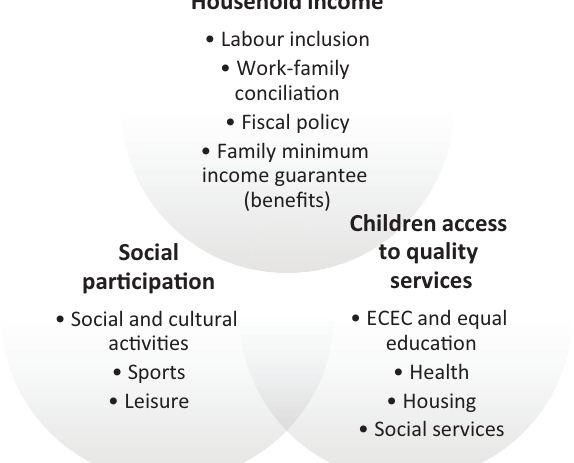
Figure 2. Model of analysis: Main dimensions. Source: Own elaboration based on TÁRKI (2010), the European Commission (2013), and Ikuspegiak—Observatorio Infancia País Vasco (2013). Social Inclusion, 2022, Volume 10, Issue 4, Pages